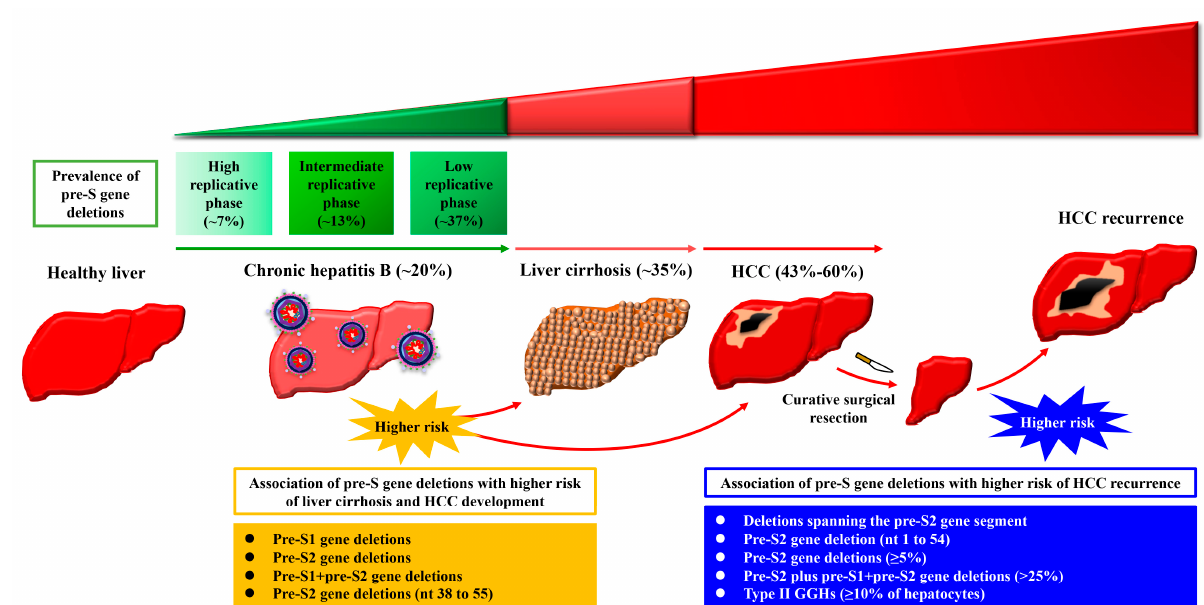
Figure 2. Schematic summary of the clinical association of HBV pre-S gene deletions with liver disease progression and HCC development and recurrence. In patients with chronic HBV infection, the prevalence of overall pre-S gene deletions (including pre-S1, pre-S2, and pre-S1 + pre-S2 gene deletions) in the blood gradually increases with liver disease progression from the high to intermediate to low replicative phases of chronic hepatitis B, to liver cirrhosis, and reaches the highest level at the stage of HCC development. The presence of pre-S gene deletions (pre-S1, pre-S2, and/or pre-S1 + pre-S2 gene deletions) or pre-S2 gene deletions between nts 38 and 55 (nt 38 to 55) predicts higher incidence of liver cirrhosis and HCC development. Moreover, in patients with HBV-related HCC, the presence of deletions spanning the pre-S2 gene segment, pre-S2 gene deletion at nts 1 to 54 (nt 1 to 54), pre-S2 gene deletions at ≥ 5%, or pre-S2 plus pre-S1+pre-S2 gene deletions at >25% in the blood or type II GGHs comprising ≥ 10% of hepatocytes in the liver tissues predicts the higher risk of HCC recurrence after curative surgical resection. Abbreviations: HCC, hepatocellular carcinoma; GGHs, ground glass